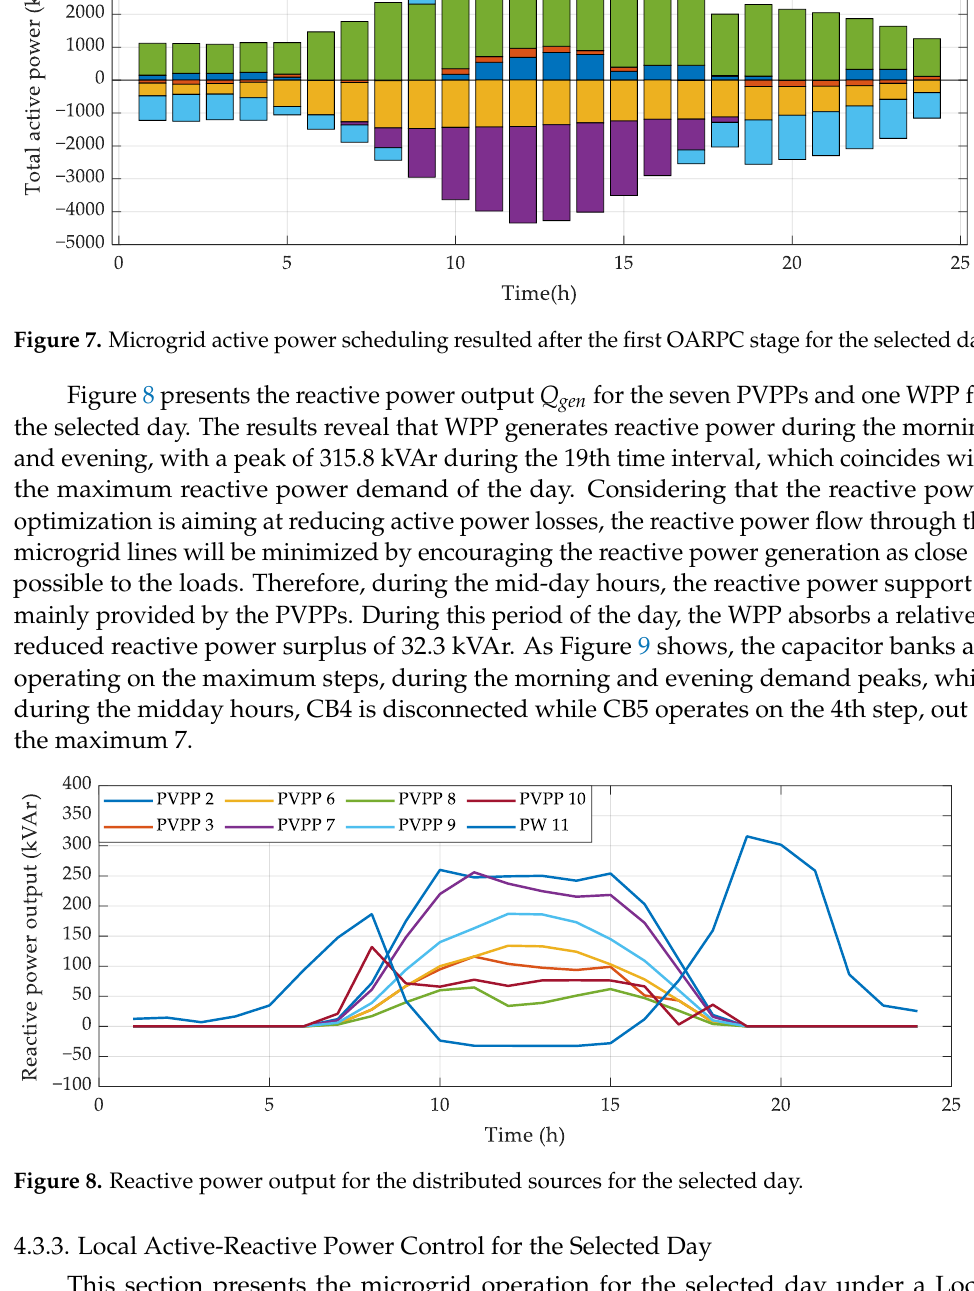
Figure 7. Microgrid active power scheduling resulted after the first OARPC stage for the selected day.